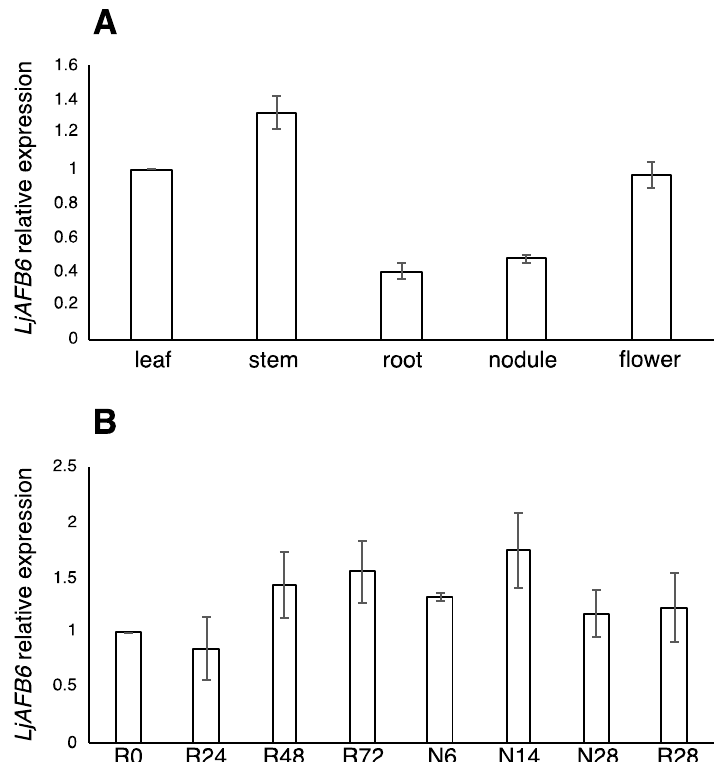
Figure 2. ( A ) LjAFB6 expression in different organs. RNAs were extracted from wild-type plants grown on Gamborg B5 derivative medium without nitrogen source at 3 weeks post inoculation (wpi). Mature flowers were obtained from L. japonicus plants propagated in the growth chamber. ( B ) Time course of expression of LjAFB6 in root and nodule tissues after M. loti inoculation. RNAs were extracted from roots of wild-type seedlings grown in nitrogen starvation conditions at different times after inoculation (R0, 24 h, 48 h, 72 h, 28 days), from nodule primordia (6 days) and mature nodules (14 days and 28 days post inoculation). Expression levels are normalized with respect to the internal control UBIQUITIN ( UBI ) gene and plotted relative to the expression of leaf ( A ) and R0 ( B ). Data bars represent means and SD of data obtained with RNA extracted from three different sets of plants and three qRT-PCR experiments.